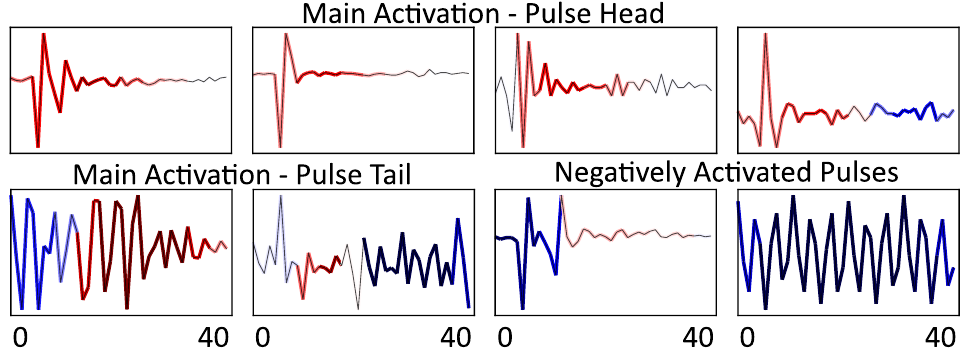
Figure 4. Pulse Activation: Some typical pulses with their activation (same color-map as in Figure 3). Upper row: pulses positively activated. Lower row left, the tail is rather considered as distinctive by the network. Lower row, right, strongly negatively activated pulses (the last one appears to be noise). The Y -axes are